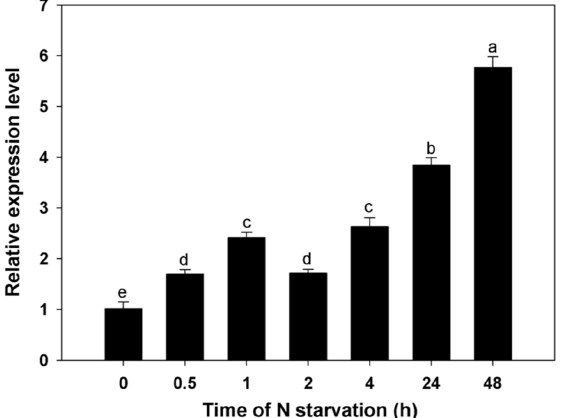
Figure 5. BcAMT1;5 expression in response to N-starvation for 0, 0.5, 1, 2, 4, 24, and 48 h. Each value shows the mean ± SE ( n = 3 ). Different lowercase letters show significant differences at p < 0.05.